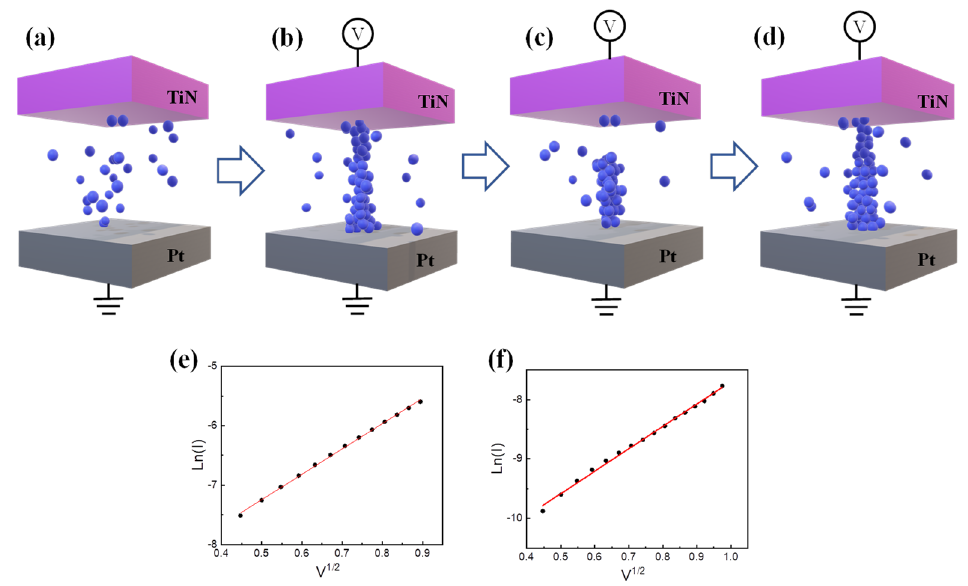
Figure 3. ( a – c ) Schematic diagram of the filament evolution for ( a ) initial state, ( b ) forming, ( c ) reset, and ( d ) set. ln(I) versus V 1/2 for Schottky emission of ( e ) LRS and ( f ) HRS.